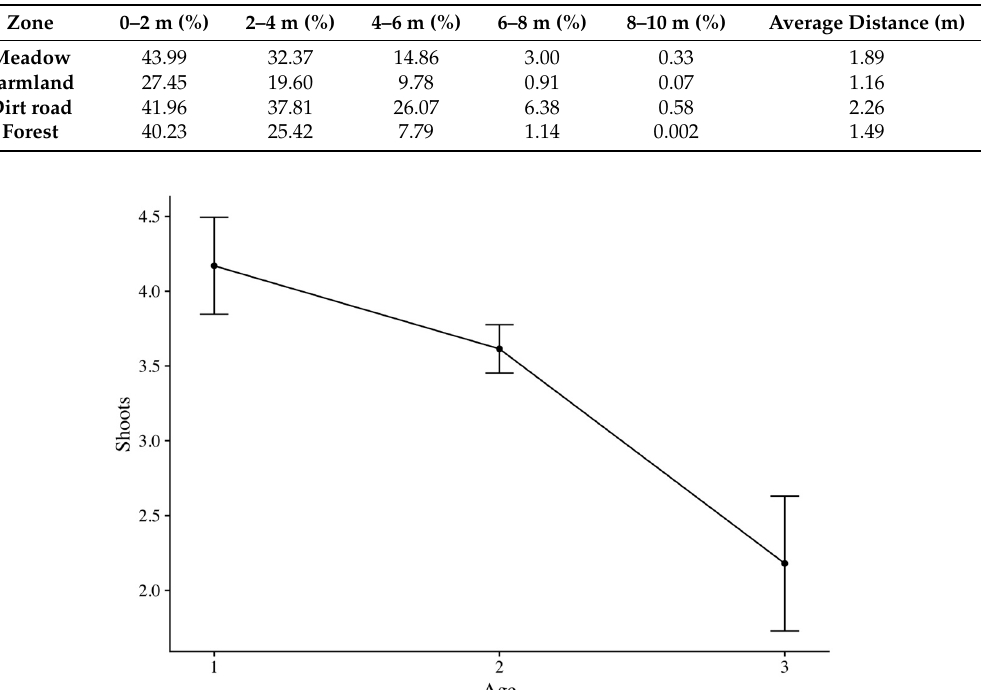
Figure 5. Average number of shoots per stump in relation to the shoot age and the standard error of the mean (data = 5244 shoots). Detailed values are presented in Table 3. Forests 2019 , 10 , x FOR PEER REVIEW